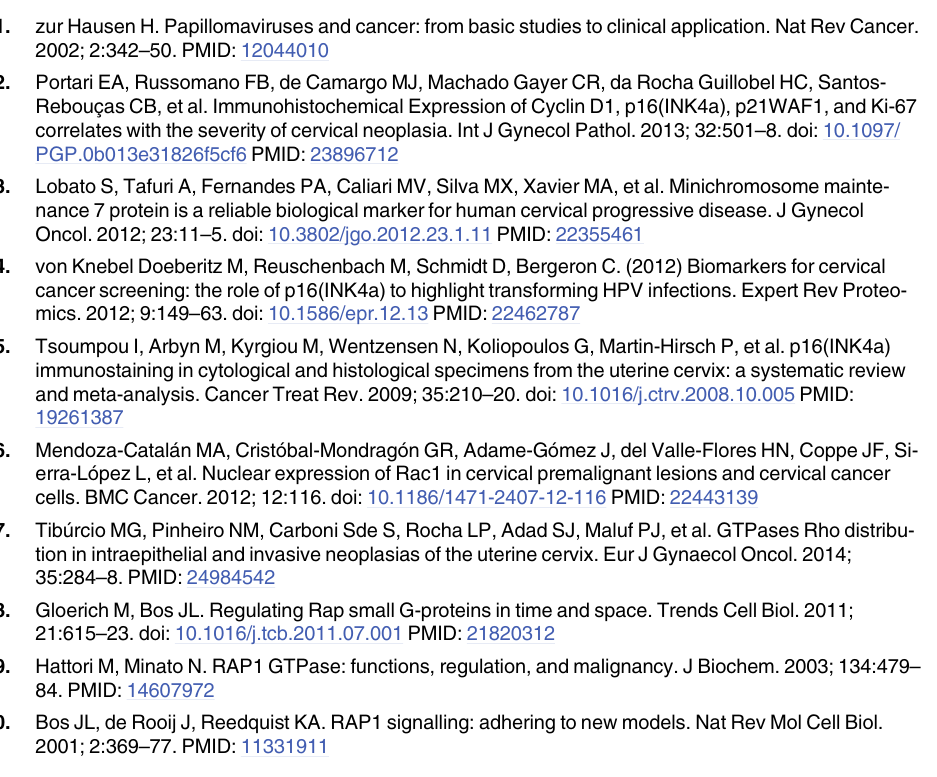
S3 Dataset. Dataset for Table 2 “ Associations between RAP1 expression and risk of CIN progression ” . S4 Dataset. Dataset for Table 3 “ Estimated coefficients, standard errors, z-scores, and two- tailed p -values for the fitted stereotype regression model ”